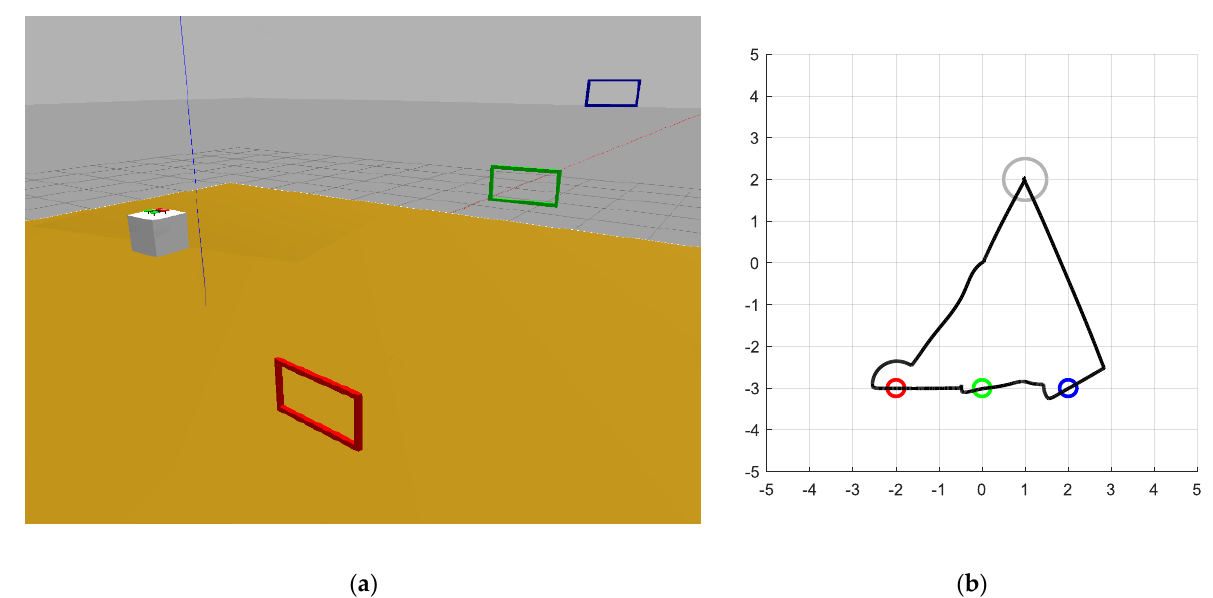
Figure 16. Test case 2: ( a ) simulated scenario (upper view); ( b ) path followed by the drone. The third and final test case study is presented in Figure 17. On this occasion, after passing through the red frame, the drone must navigate to the center of the scenario and rotate to find the green frame. It is luckier with the blue frame, which enters its camera’s field of view before it reaches the center.